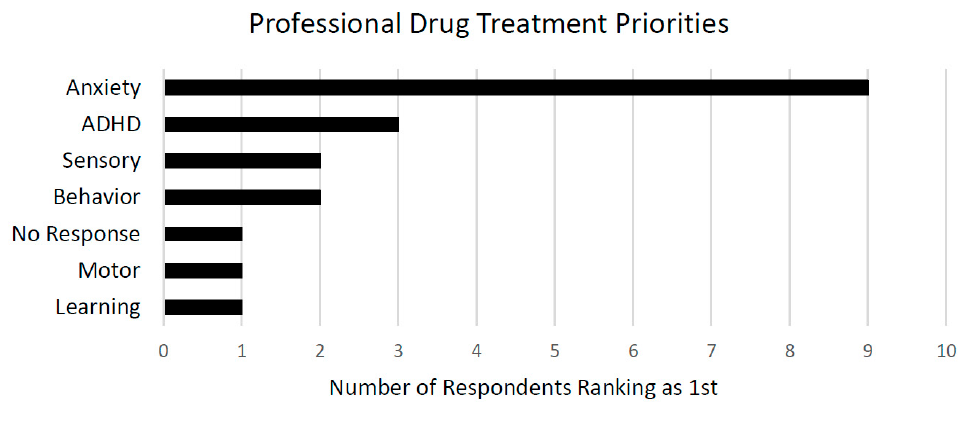
Figure 4. Family/caretaker ( A ) and professional drug ( B ) treatment priorities.